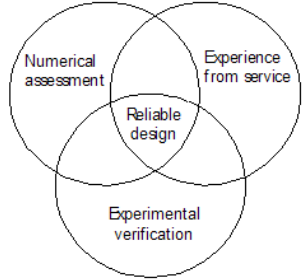
C ONCLUSIONS AND S UMMARY